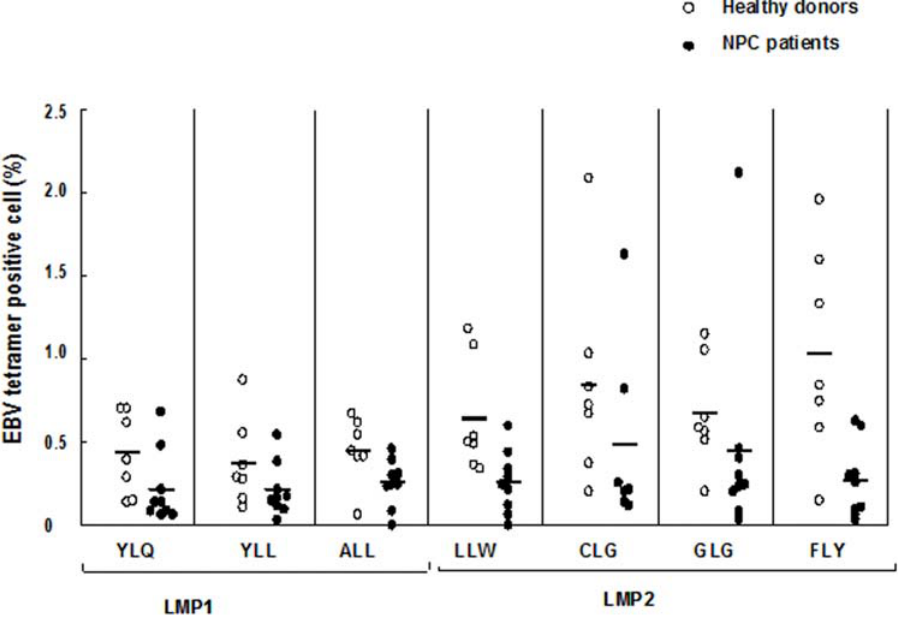
Figure 3. Frequency of LMP1 and LMP2 epitope- specific T cells in PBMCs from healthy donors and NPC patients. The frequency of T cells specific for HLA A2 restricted on LMP1 and LMP2 was detected by EBV tetramer staining and FACS analysis in freshly isolated PBMCs from healthy donors (n=7) and NPC patients (n=9). The number of tetramer positive cells in 100 lymphocytes are shown in the figure.